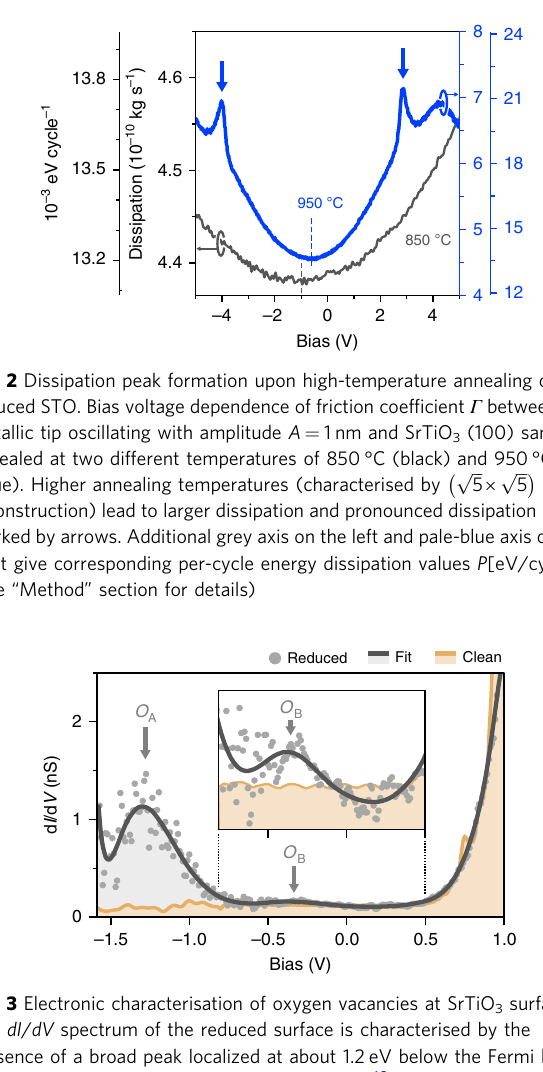
Bias Fig. 3 Electronic characterisation of oxygen vacancies at SrTiO 3 surface. The dI / dV spectrum of the reduced surface is characterised by the presence of a broad peak localized at about 1.2 eV below the Fermi level ( O A ), a signature of an oxygen-de fi cient system 42 . A smaller peak O B just below the Fermi level (see inset) can also be attributed to oxygen impurity levels (see “ Discussion ” ). For comparison, the spectrum for non-reduced sample is shown in beige (light